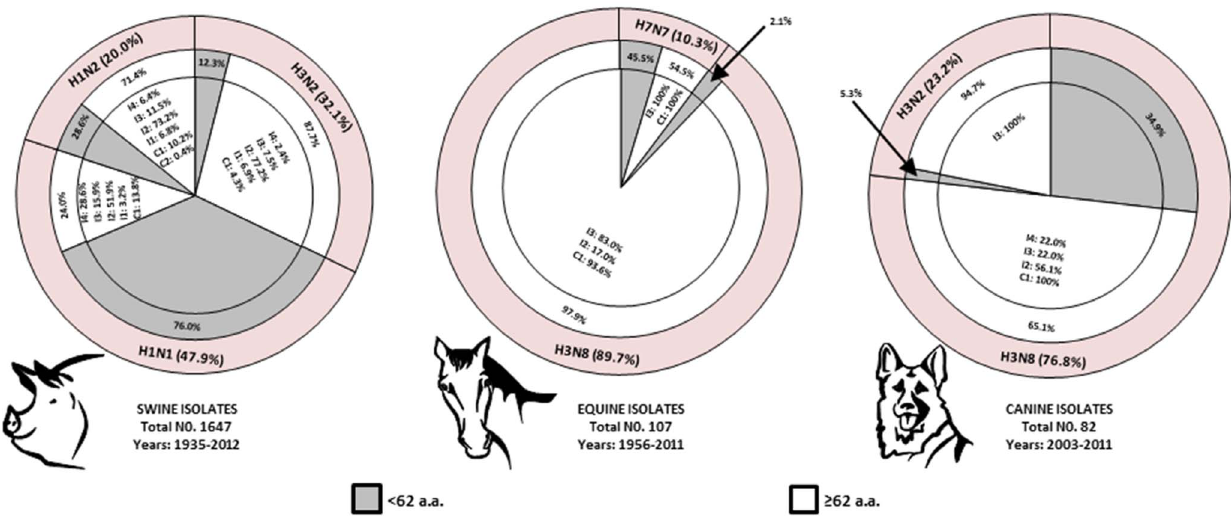
Figure 1. Genetic markers of virulence in the PB1-F2 proteins from influenza viruses of domestic mammals. The IAV isolates of swine, horses, and dogs were categorized into the lineage (outer ring), PB1-F2 length (middle ring), and combination of inflammatory (indicated as ‘‘I’’) and cytotoxic (indicated as ‘‘C’’) residues (inner ring). Within the outer ring, the percentage of each grouping is shown relative to the total number of isolates. Within the middle and inner rings, the percentage of each grouping is shown relative to the preceding grouping. The numbers of inflammatory (indicated as ‘‘I1’’ through ‘‘I4’’) and cytotoxic (indicated as ‘‘C1’’ and ‘‘C2’’) residues were determined for PB1-F2 proteins with length of 62 or more amino acids (e.g. capable of encoding either inflammatory or cytotoxic